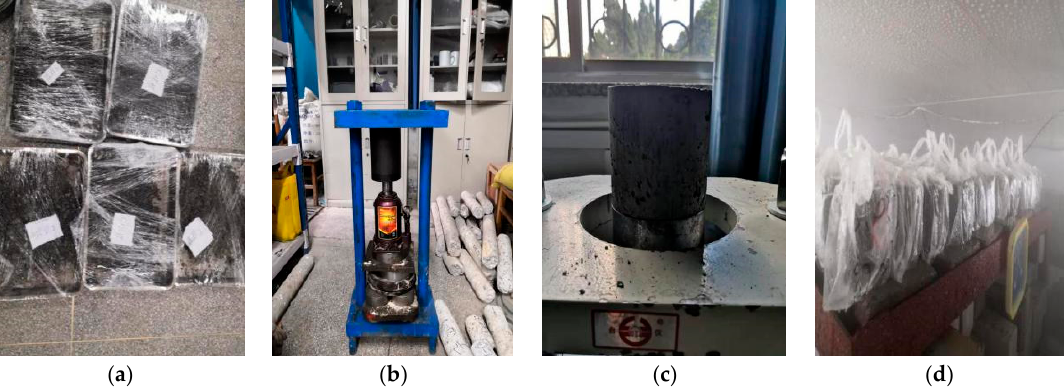
Figure 4. Specimen-making for unconfined compressive strength test: ( a ) Stuffy material; ( b ) Static pressure; ( c ) Demolding; ( d ) Curing.